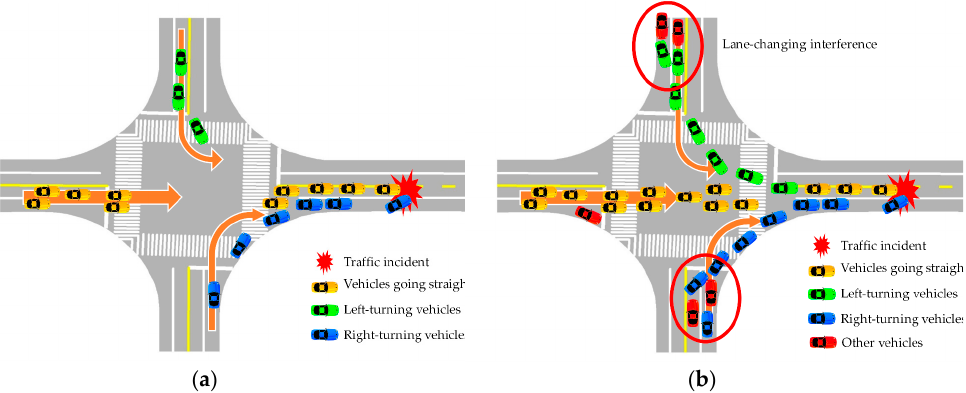
Figure 6. ( a ) Queuing propagation at an intersection. Vehicles drawn in different colors take different trajectories; ( b ) Interference of vehicles taking turns and going straight.